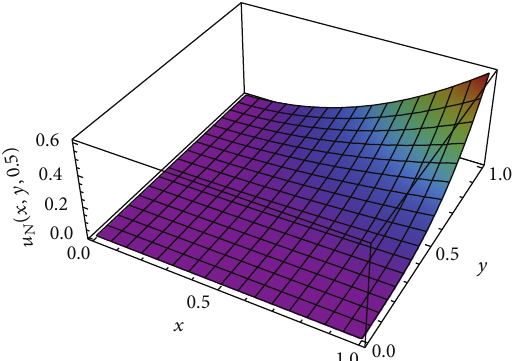
Figure 7: 𝑥 -direction curve of absolute error of problem (46) at ] 1 = = 1.5 and 𝑁 = 𝑀 = 10 . ] 2